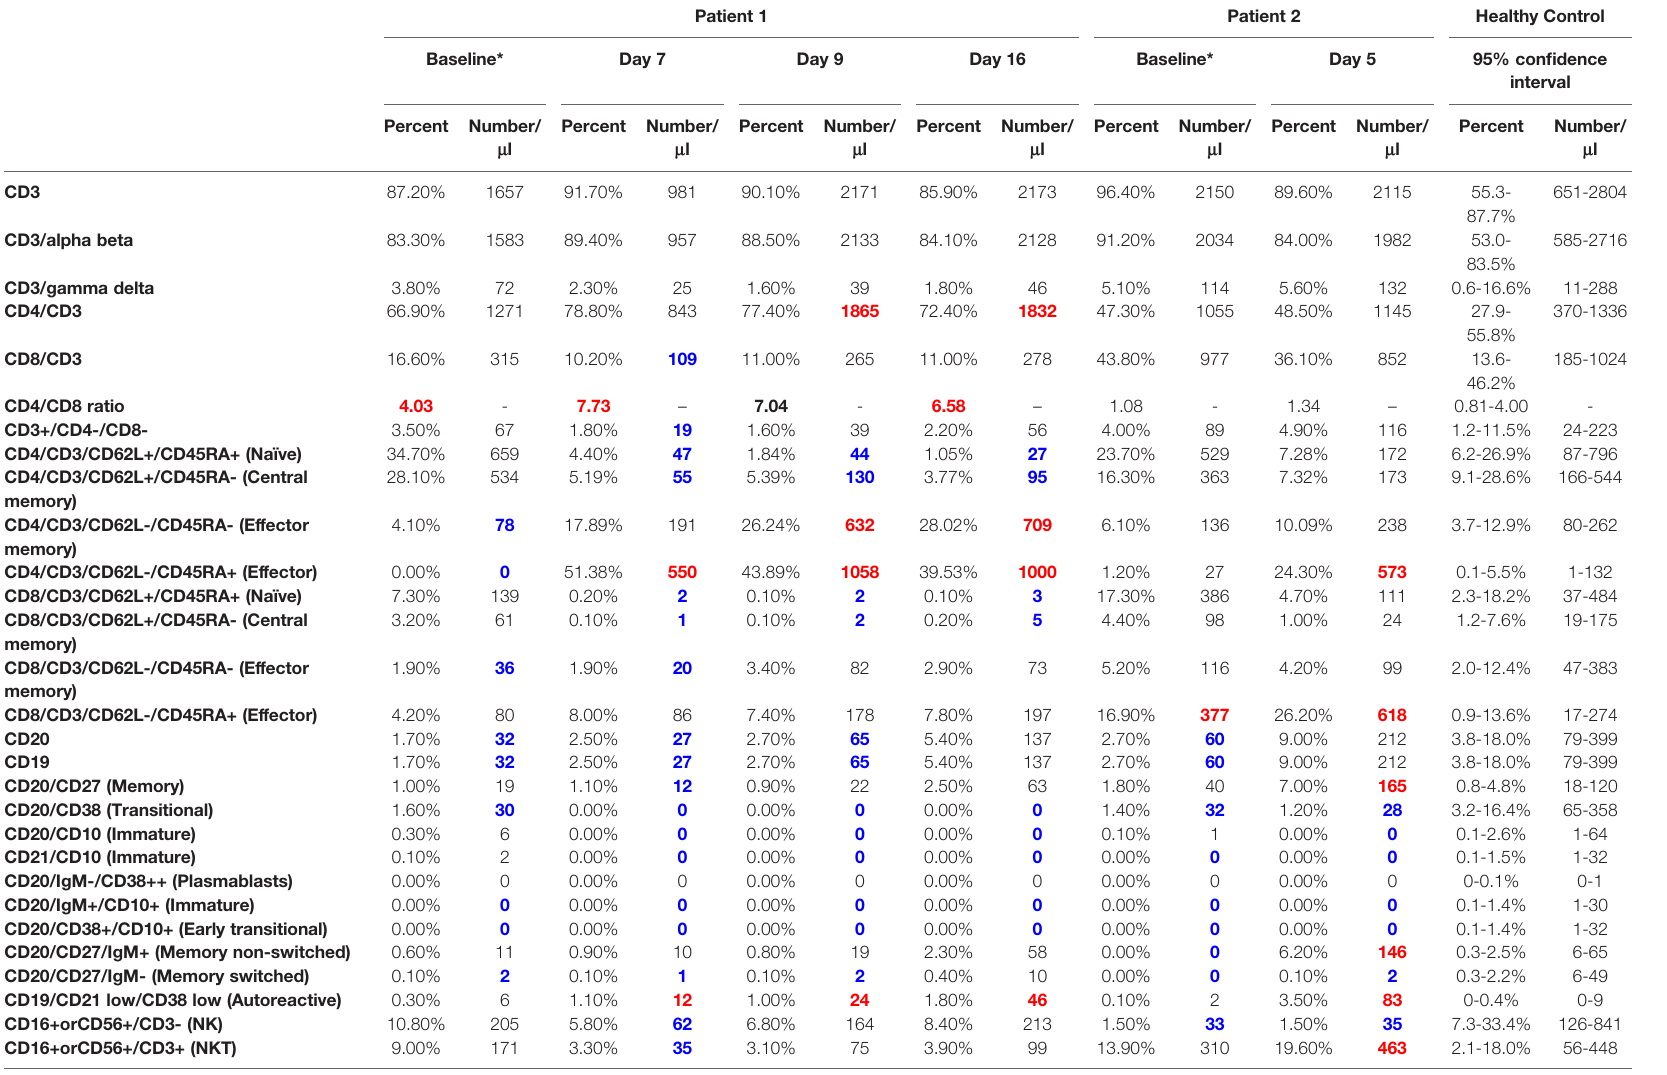
TABLE 2 | Lymphocyte subsets before COVID-19 and during the course of COVID-19 infection in the APECED patients included in our